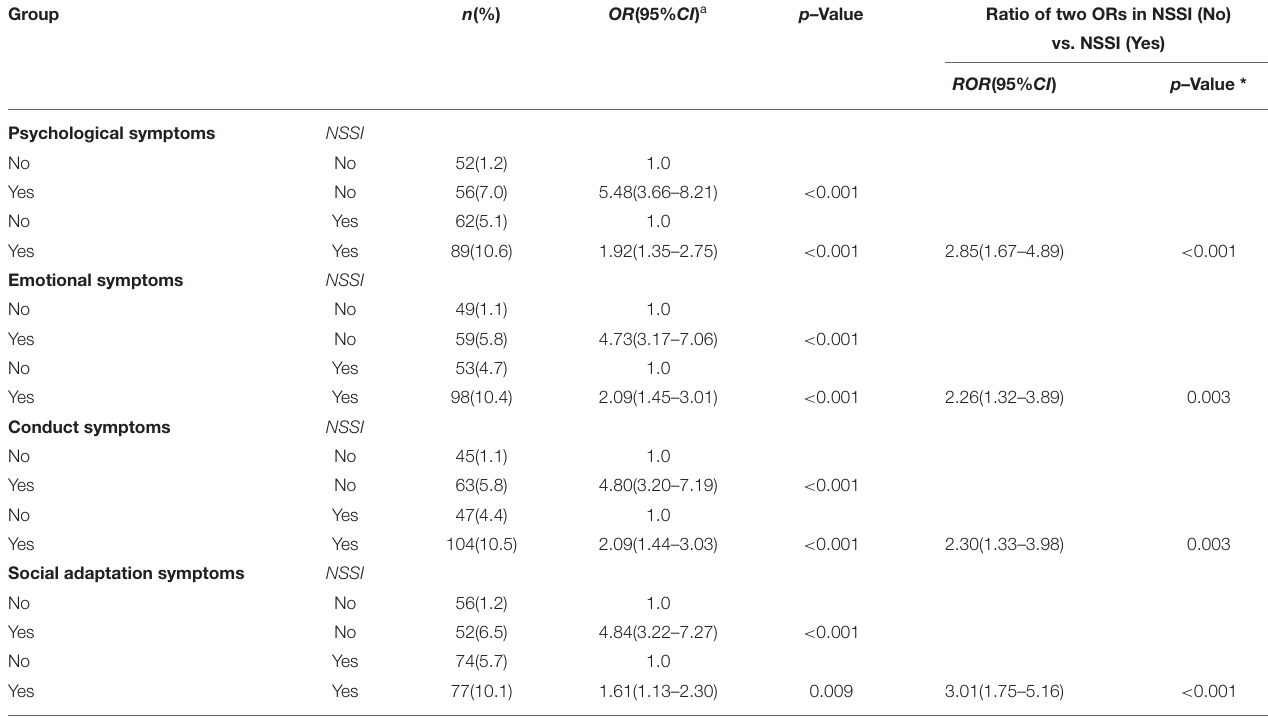
TABLE 3 | Number, % and adjusted OR of SA by psychological symptoms and NSSI in males. Group n (%) OR (95% CI ) a p– Value Ratio of two ORs in NSSI